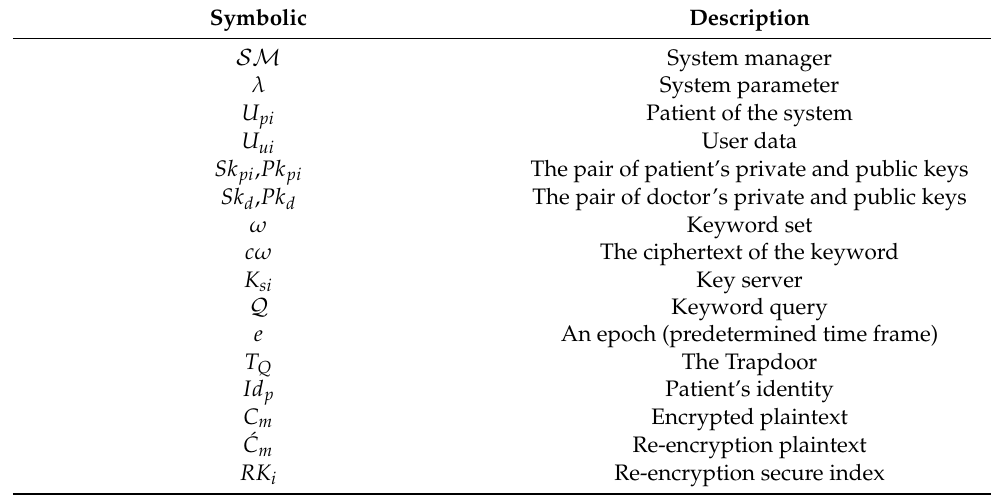
Table 1. Proposed protocol symbolic